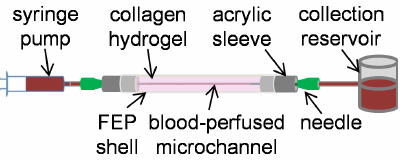
Figure 1. Diagram of blood-perfused collagen vessel bioreac- tor.